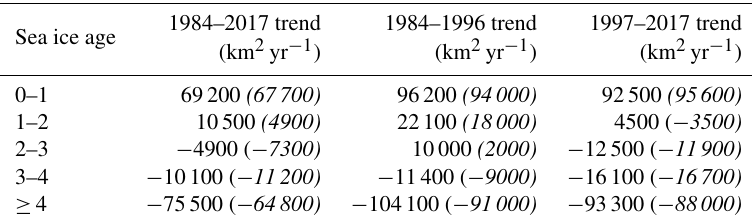
Table 3. Linear trends for ice ages over three periods. The main values are for Version 4, with Version 3 values in italics on the line below. These values are for the Arctic Ocean